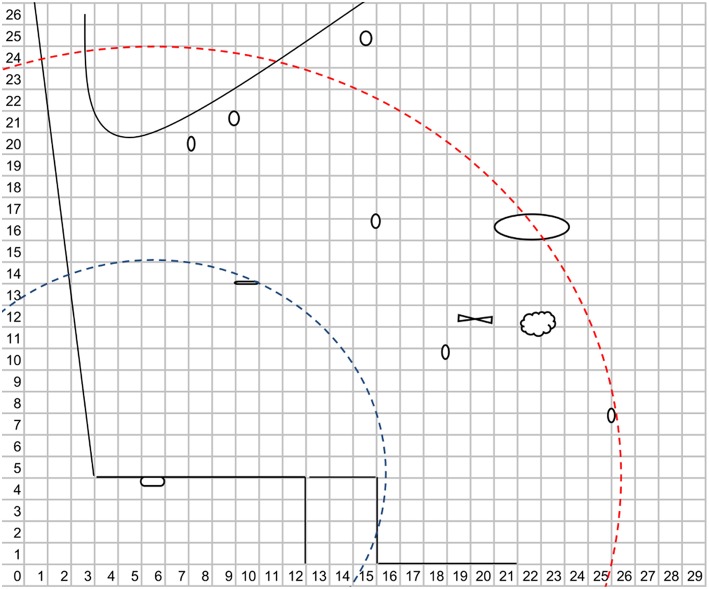
Schema used to record individuals' spatial position. The scale of this schema is 1 m2. Circles, ellipses, and polygons represent trees and bushes where the mandrill could get covered. The line on the upper side represents the beginning of the forest area. The feeding zone is contained to X = 12–15 and Y = 0–4 and the door is represented by the polygon in X = 5–6 and Y = 3–4. The two circular buffers are characterized by the 10 m (blue) and the 20 m (red) areas used to calculate frequencies of observation.